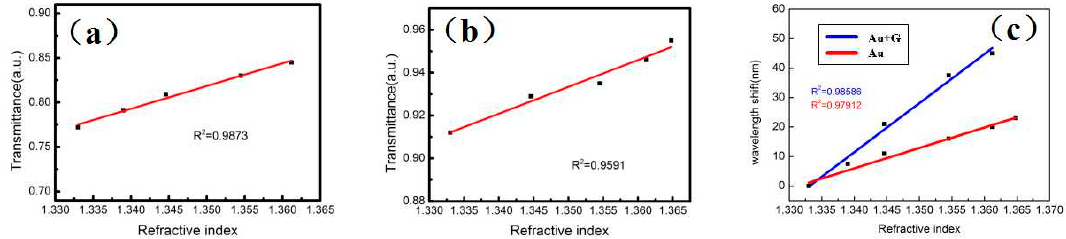
Figure 5. ( a ) Linear relationship between the lowest transmittance of the normalized transmission